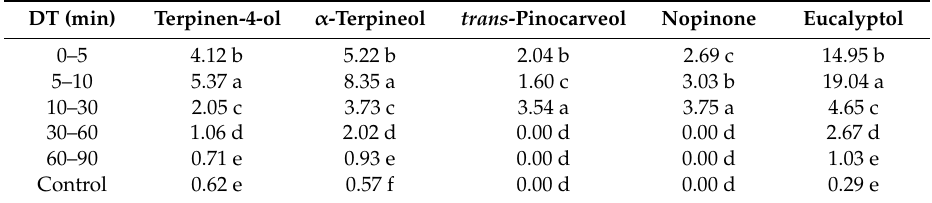
Table 4. Mean concentrations (%) of Ruta graveolens fruit EO (terpinen-4-ol, α -terpineol, trans-pinocarveol, nopinone, and eucalyptol) obtained from the six distillation times (DT). Control = nonstop 0–90 min.